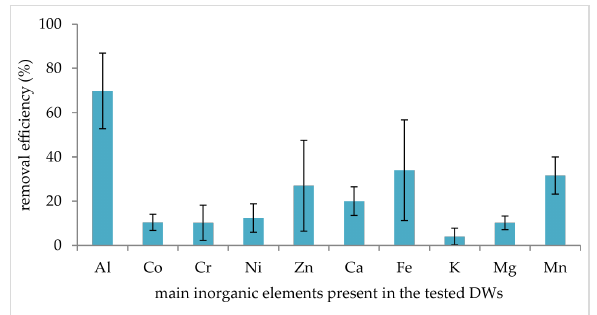
Figure 8: Removal efficiency (%) of inorganic elements after treat- ment of five DWs by polyBTCA-CD (concentrations = 2 g·L − 1 , n =